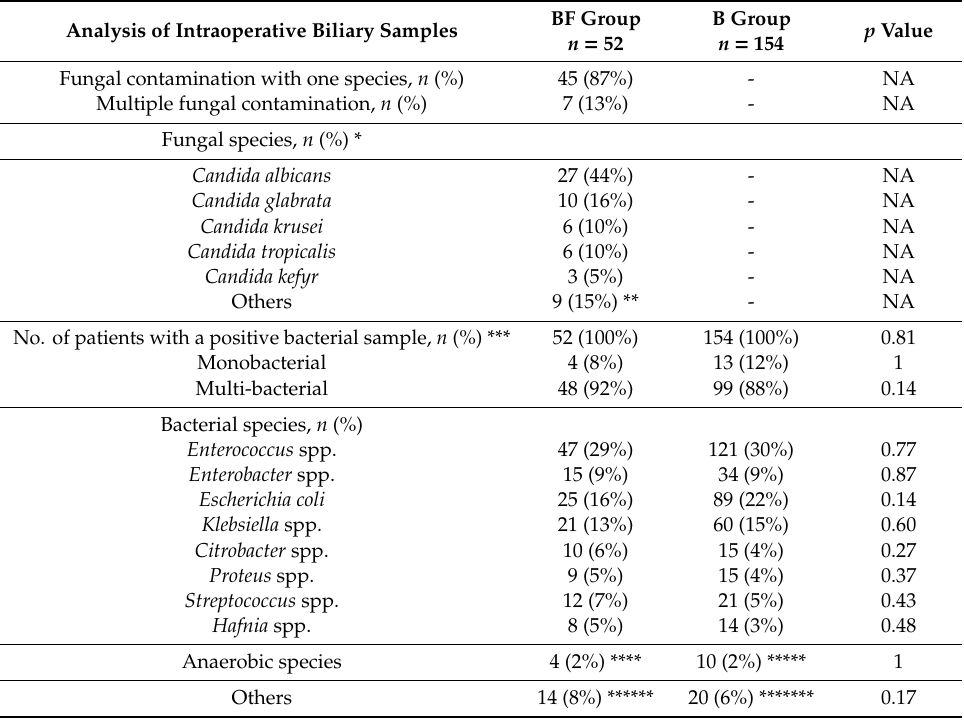
Table 3. Analysis of intraoperative biliary